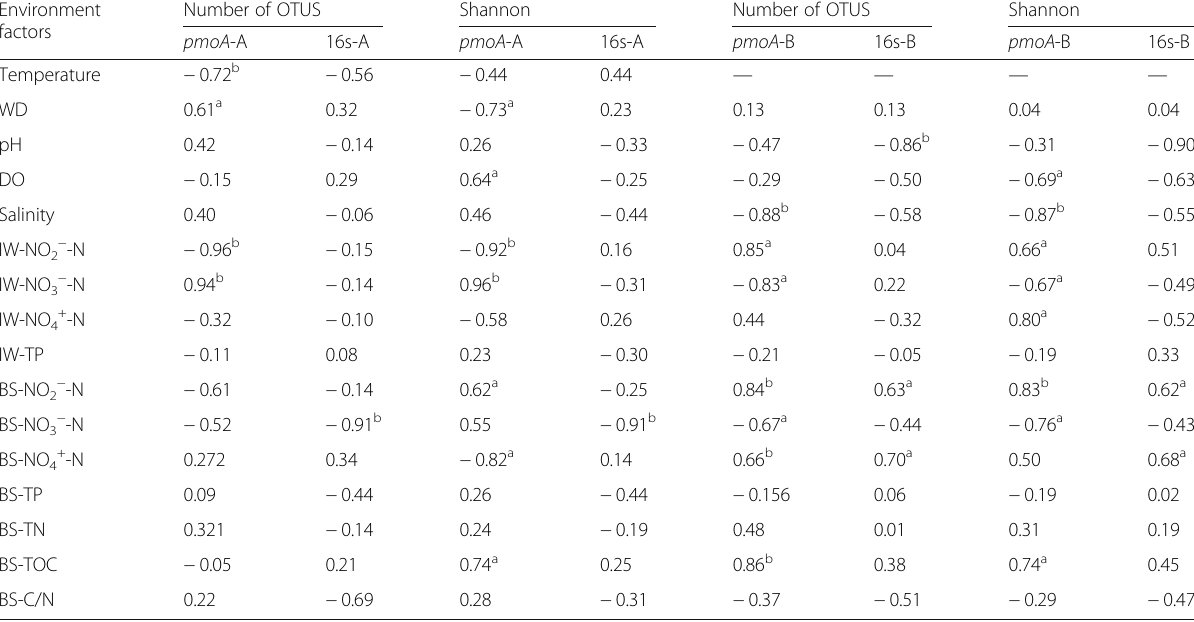
Table 3 Spearman ’ s correlation between abiotic environment factors and biodiversity of N-DAMO bacteria (16S rRNA and pmoA genes) in Miyun Reservoir Environment